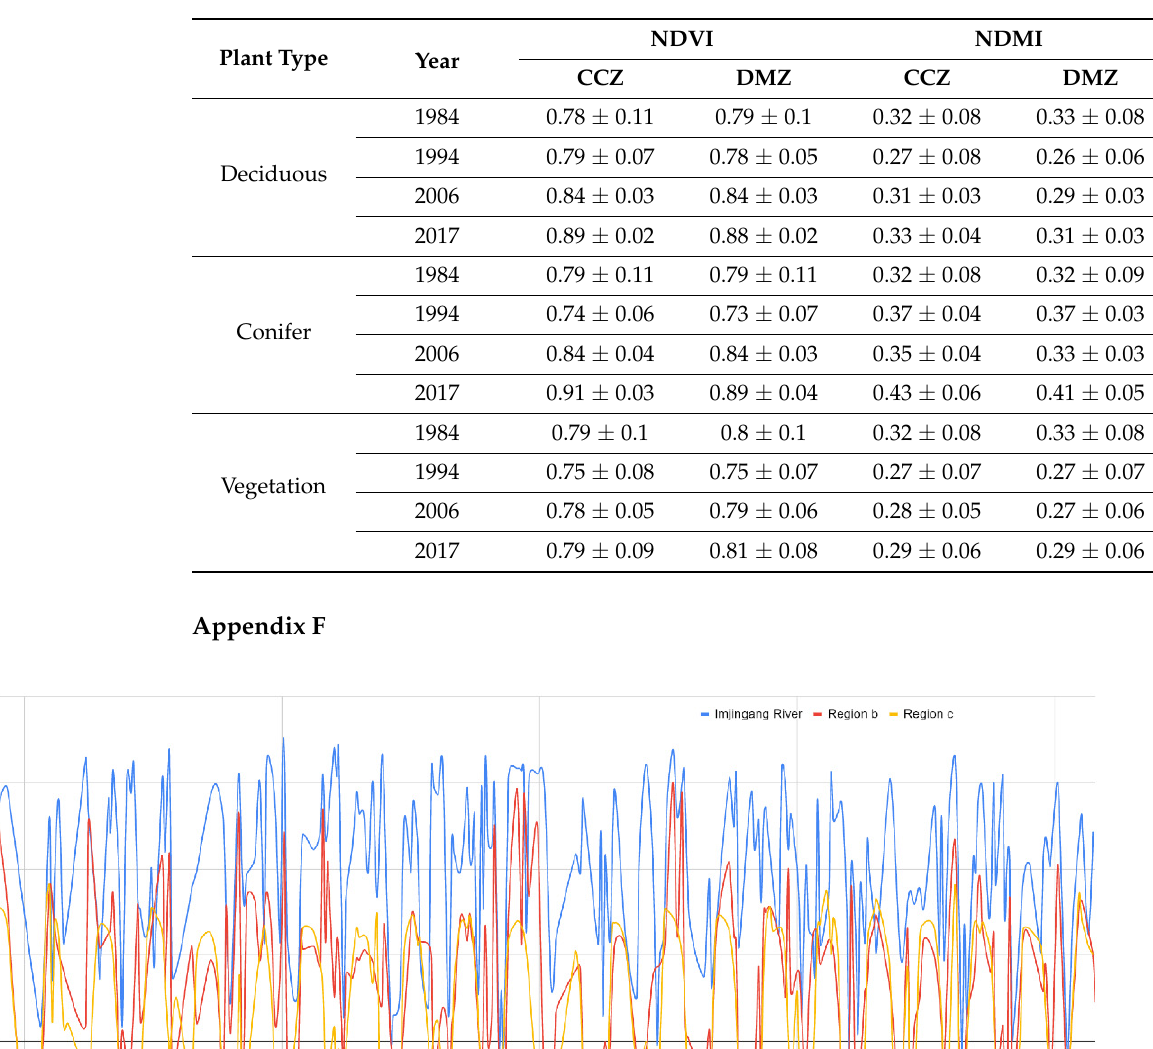
Table A2. Average NDVI and NDMI values depending on plant types of corresponding years (Mean ± SD). There were no significant differences between CCZ and DMZ within a year.